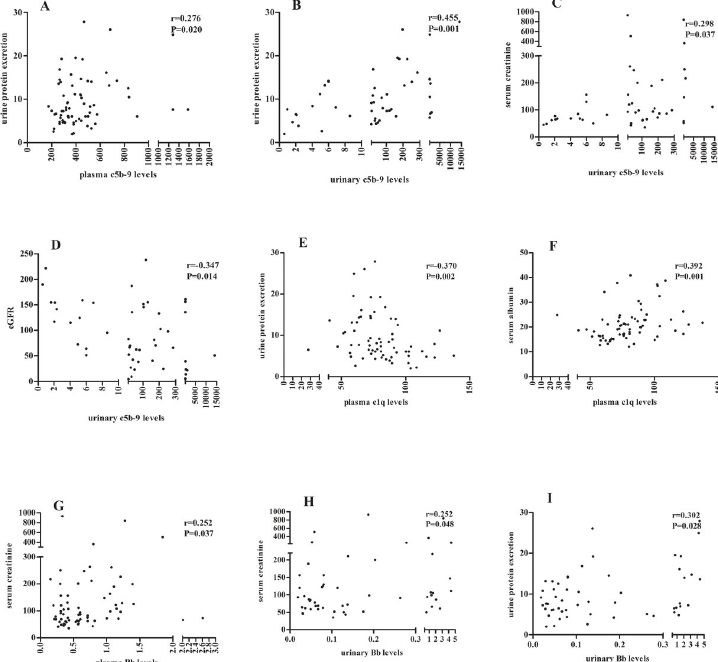
Fig 5. Associations between complement components and clinical-pathologic parameters. The plasma (A) and urinary (B) levels of soluble C5b-9 were positively correlated with urinary protein excretion. The urinary C5b-9 level was positively correlated with the concentration of serum creatinine (C) and negatively correlated with eGFR (D). The plasma level of C1q was negatively correlated with urinary protein excretion (E) and positively correlated with serum albumin (F). The plasma (G) and urinary (H) level of Bb was positively correlated with serum creatinine. The urinary Bb level was positively correlated with urinary protein (I).